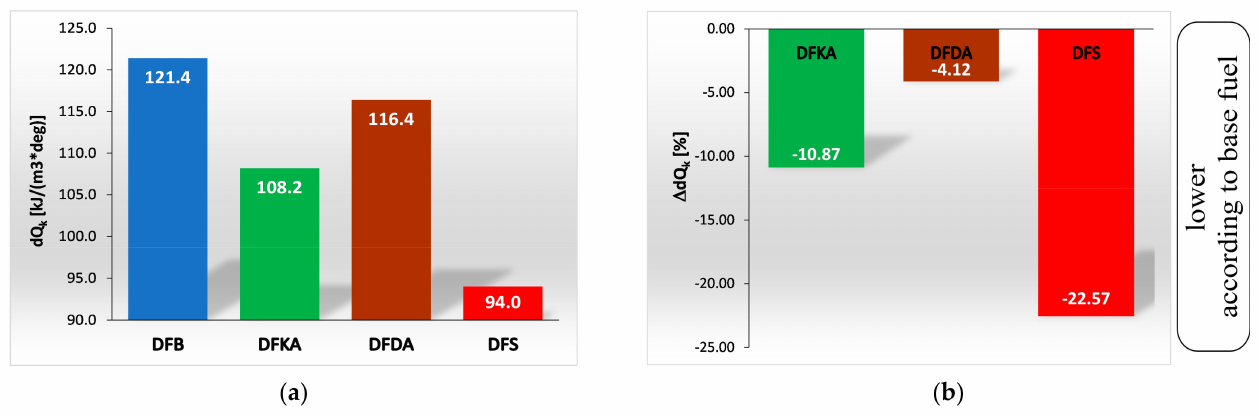
Figure 19. ( a ) Maximum kinetic combustion rate (dQ k ) for tested fuels. ( b ) Percent change in maximum rate of kinetic combustion ( ∆ dQ k ) for tested fuels relative to dQk for DFB (base